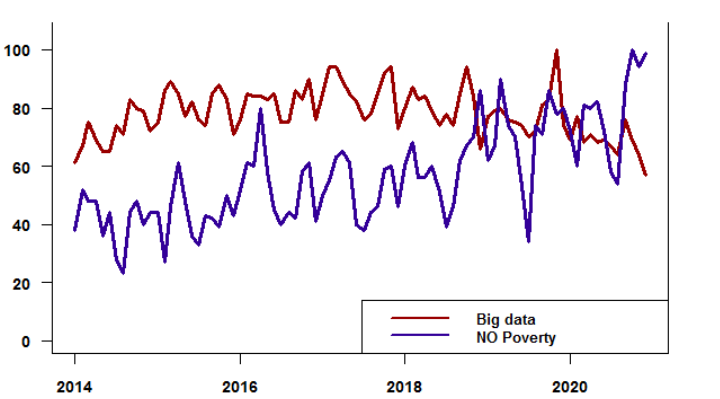
Figure 2. Big Data and SDG 1 global Google trends since